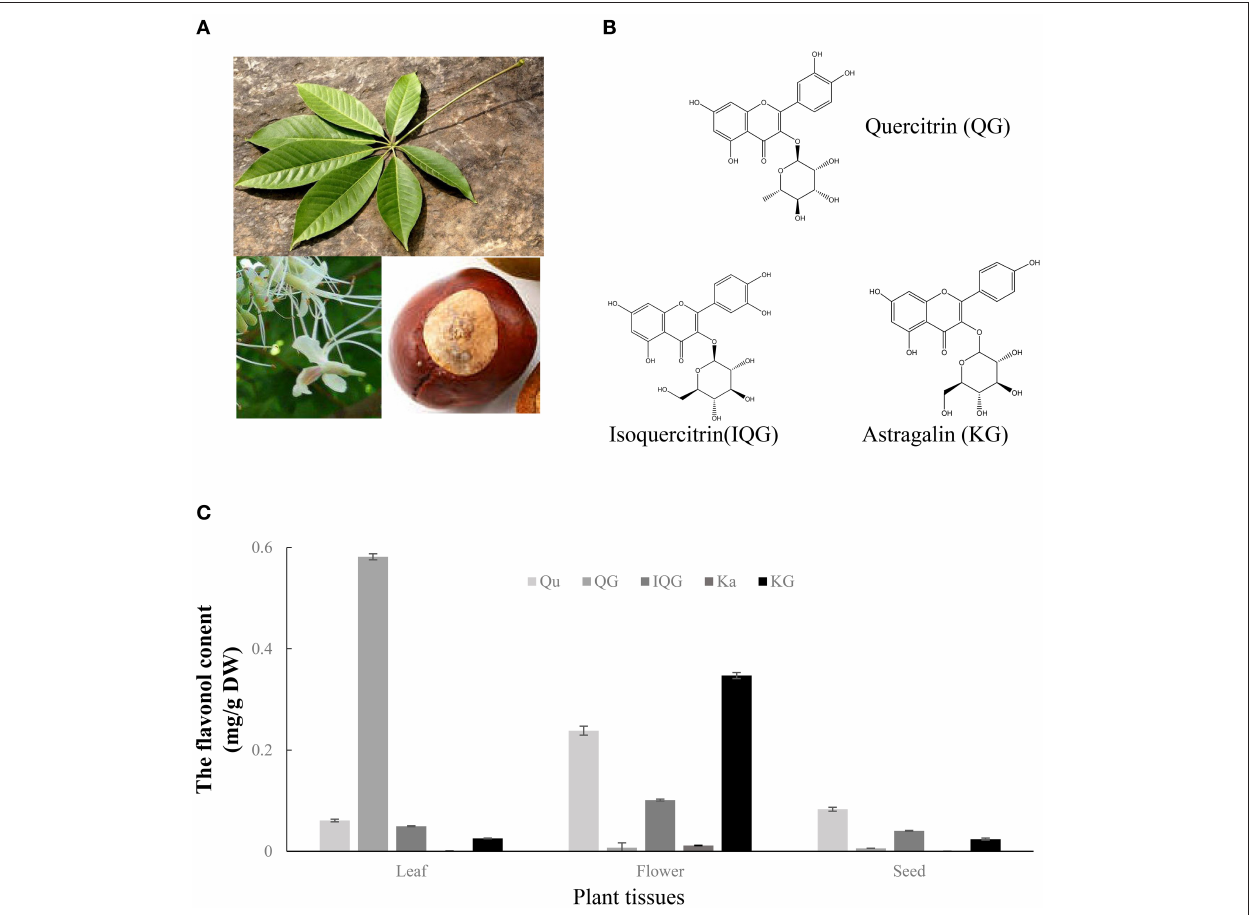
FIGURE 2 | Flavonol glycosides in different tissues of A. chinensis . (A) Images of the seeds, flowers, and leaves of A. chinensis . (B) The molecular structures of three main flavonol glycosides. (C) The contents of flavonols in the three tissues. Qu, quercetin; Ka, kaempferol; IQG, isoquercitrin; KG, astragalin; QG, quercitrin.